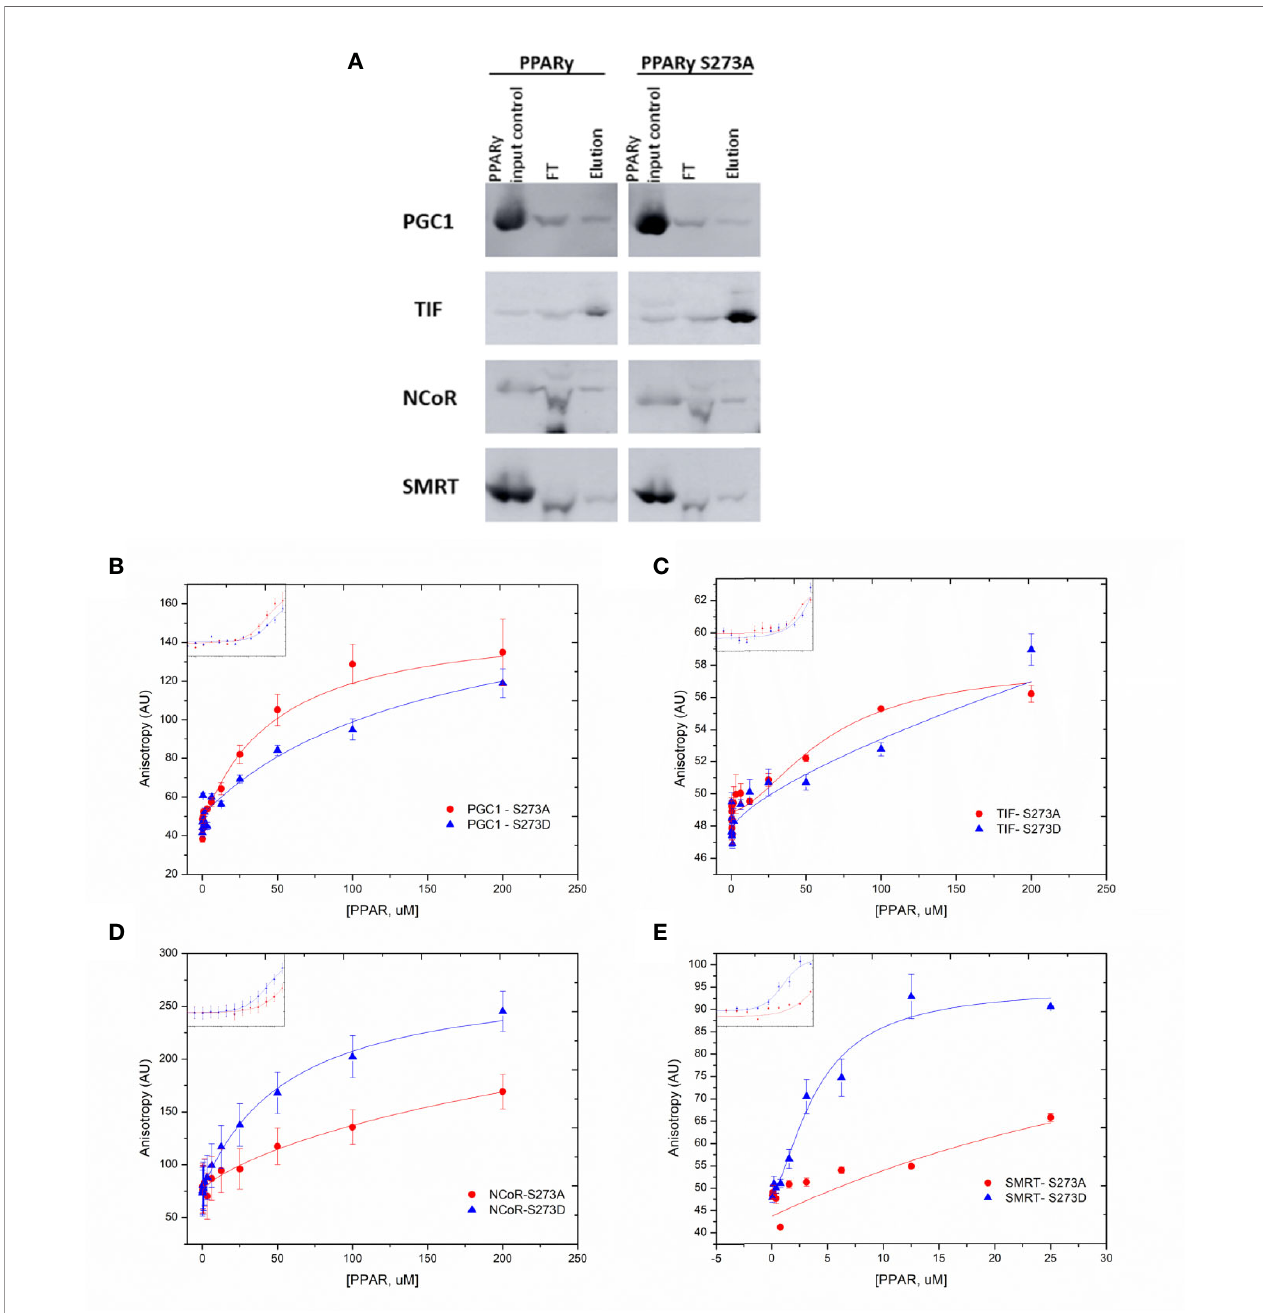
FIGURE 4 | Differential PPARg: coregulator interactions. (A) Western blotting analysis of PPARg: coregulator complexes. Tagged coregulators protein extracts were used as bait to bind PPAR g and PPAR g S273A by af fi nity chromatography. The con fi rmation of complex formation is showed using an antibody against PPAR g in pull-down eluted samples. (B – E) Fluorescence anisotropy measurements obtained from the titration of PPAR g wt, S273A and S273D mutants into fl uorescein- labeled coregulators. (B) PGC1- a anisotropy measurements. (C) TIF2 anisotropy measurements. (D) NCoR anisotropy measurements. (E) SMRT anisotropy measurements. The experimental controls and kd values are in Supplementary Material